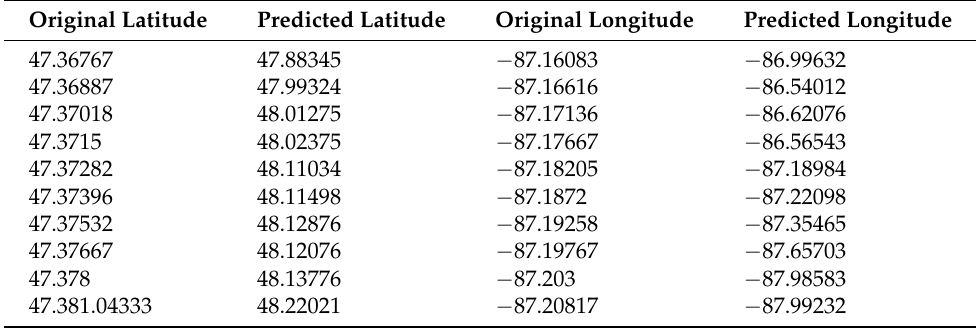
Table 4. Real data contrasted with the previously predicted path segment on the second sample. Original Latitude Predicted